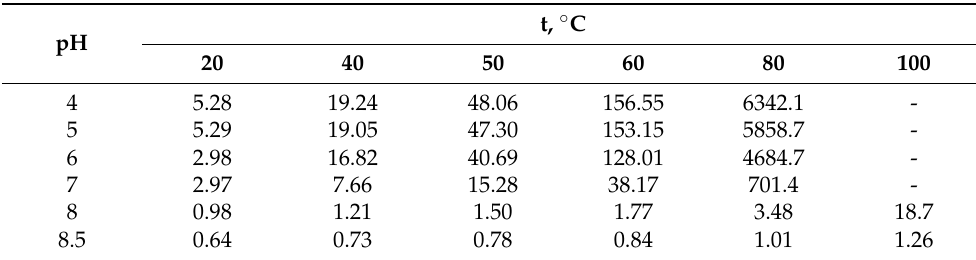
Table 5. The final average radius of silica particles at a constant temperature and varying pH (nm). C s (t = 0) = C t = 700 mg/kg.